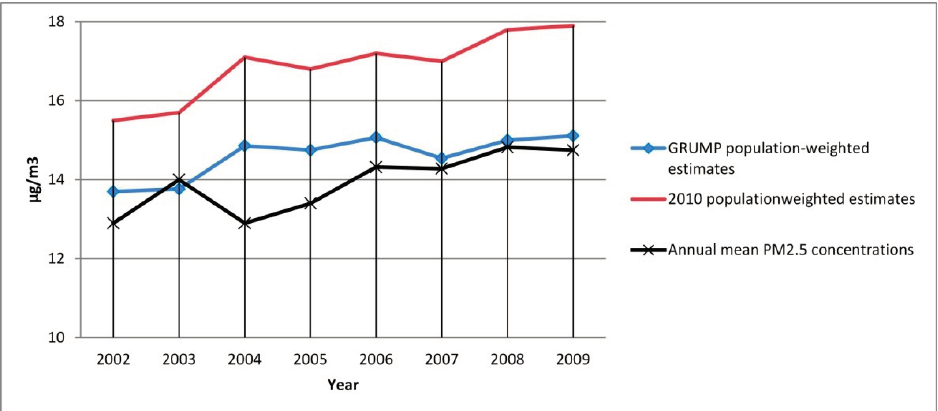
Figure 2. Population-weighted PM 2.5 estimates (2002–2009).